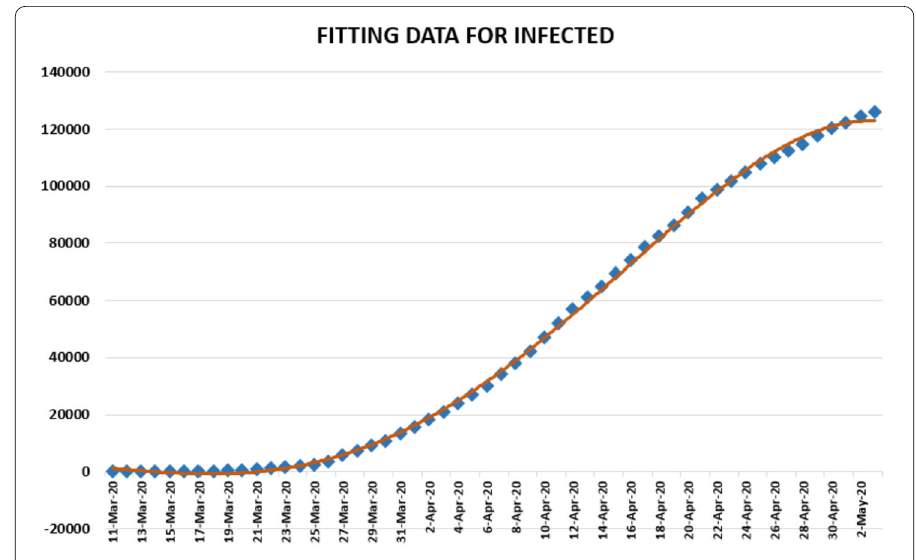
Figure 13 Polynomial fitting for infected people in Turkey from 11 March 2020 to 3 May 2020